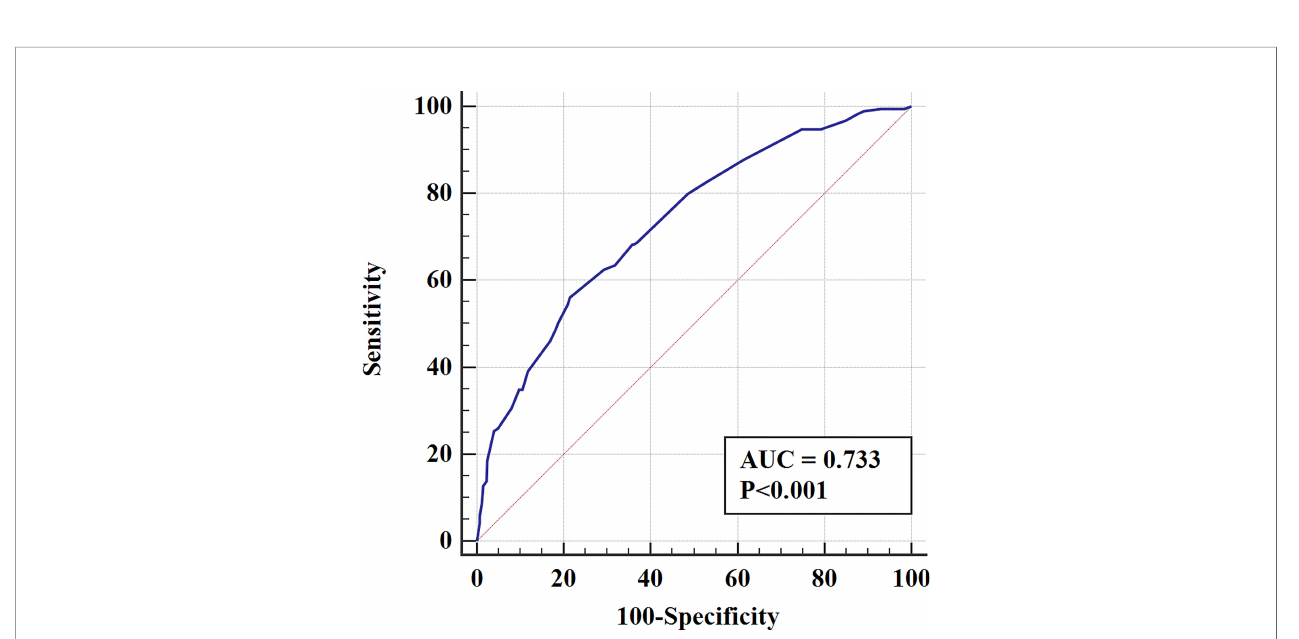
FIGURE 1 | Nomogram for predicting all cause early death in patients with pheochromocytoma and paraganglioma.